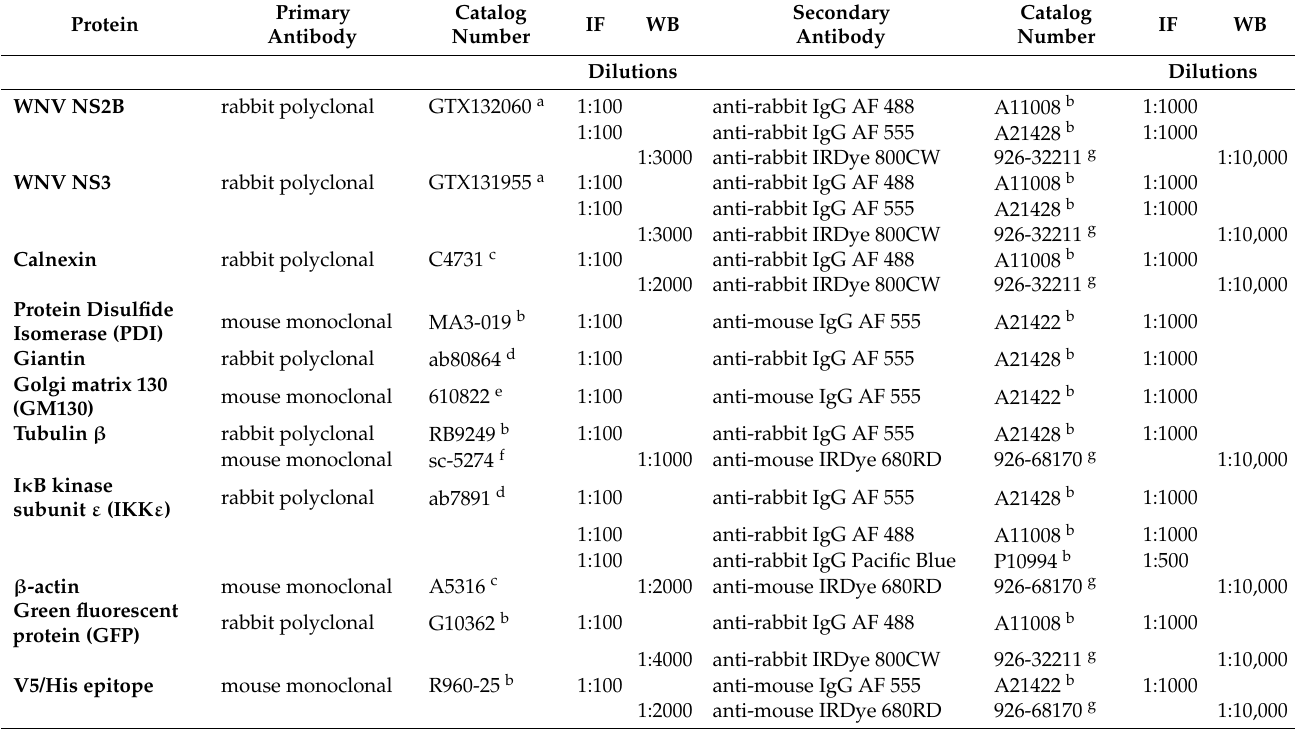
Table 2. Antibodies used for immunofluorescence (IF) and western blot (WB)